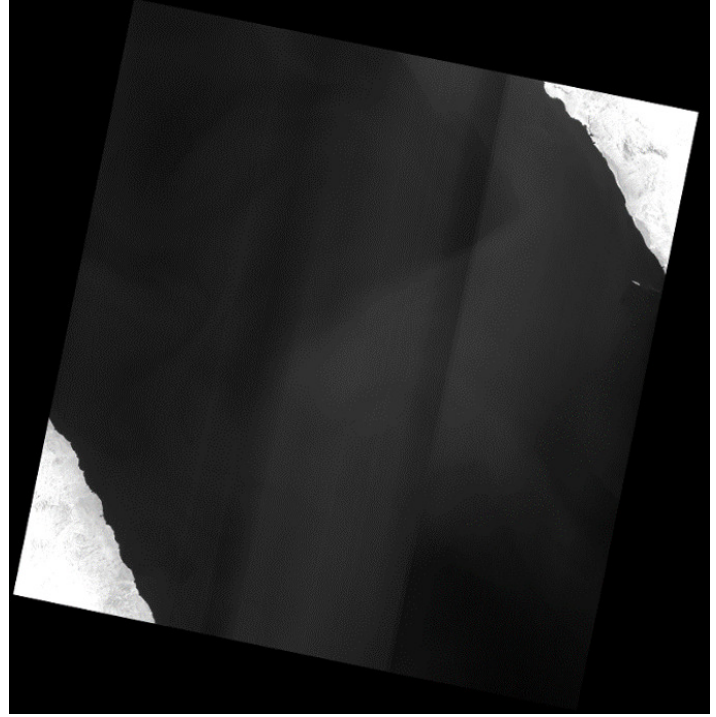
Figure 11. TIRS Band 11 image of Path/Row 173/41 (14 August 2013) in the Red Sea. The image data from the three focal plane arrays is evident due to banding in the across-track direction that varies in the along-track